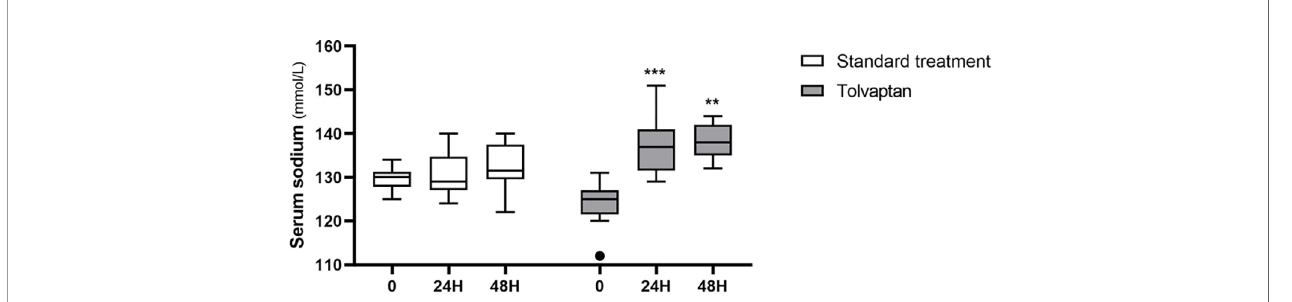
FIGURE 3 | Serum sodium 24 hours and 48 hours after administration of standard treatments (white boxes) or tolvaptan (grey boxes). **p < 0.01; ***p < 0.001, vs. pre-treatment sodium levels (time 0).